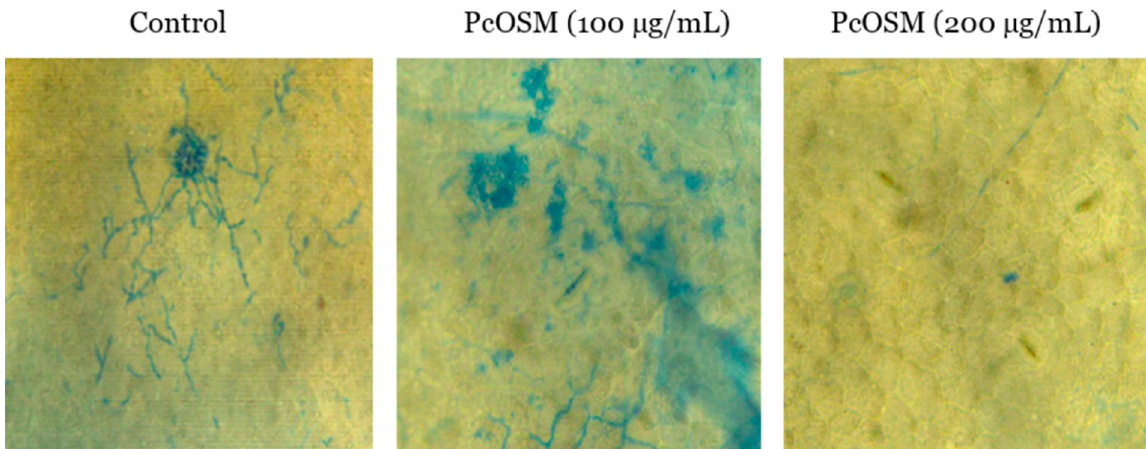
Figure 2. Inhibitory role of PcOSM on Phytophtora capsici. Control Piper nigrum leaf disc infected with P. capsici . In vivo hyphal lysis of PcOSM- Piper nigrum leaf infiltrated with PcOSM 100µg/mL and 20o µg/mL and infected with P. capsici 1 h after infiltration. The leaf discs showed significant hyphal breakage of P. capsici followed by inhibition of mycelial growth.